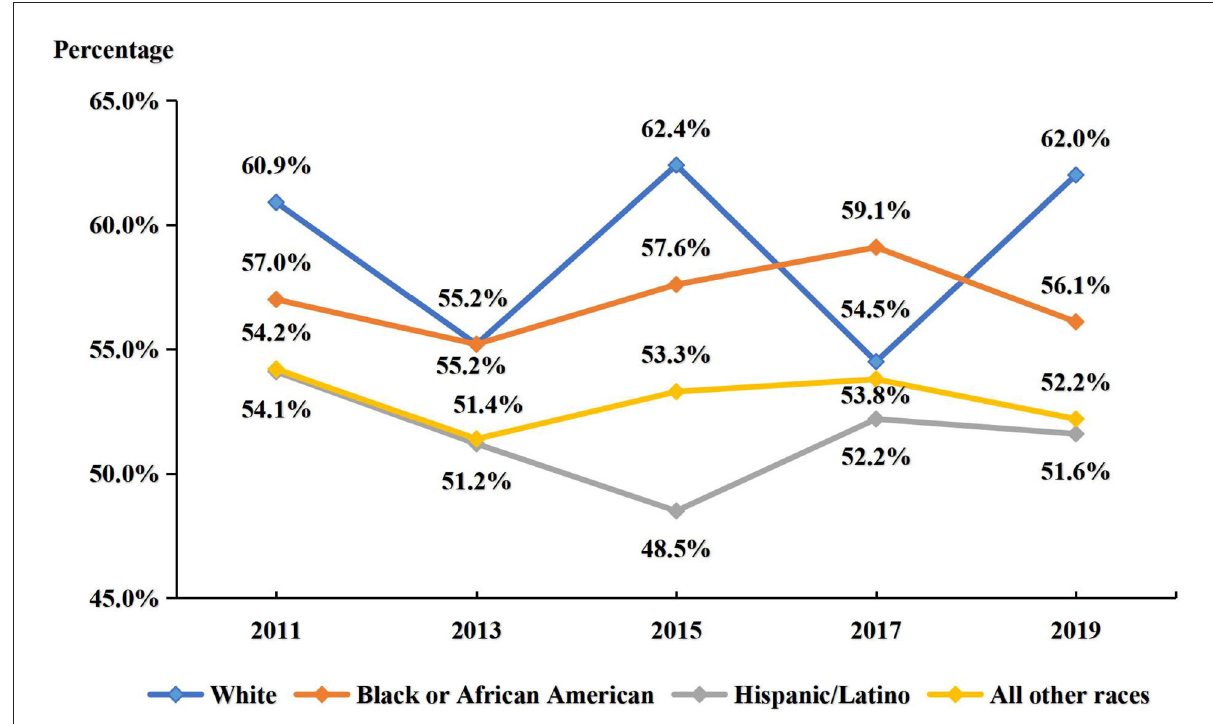
FIGURE3 Prevalence of participating in at least one sports team over the past 12 months in the sample (by race/ethnicity) between 2011 and 2019. All models were controlled for sex and